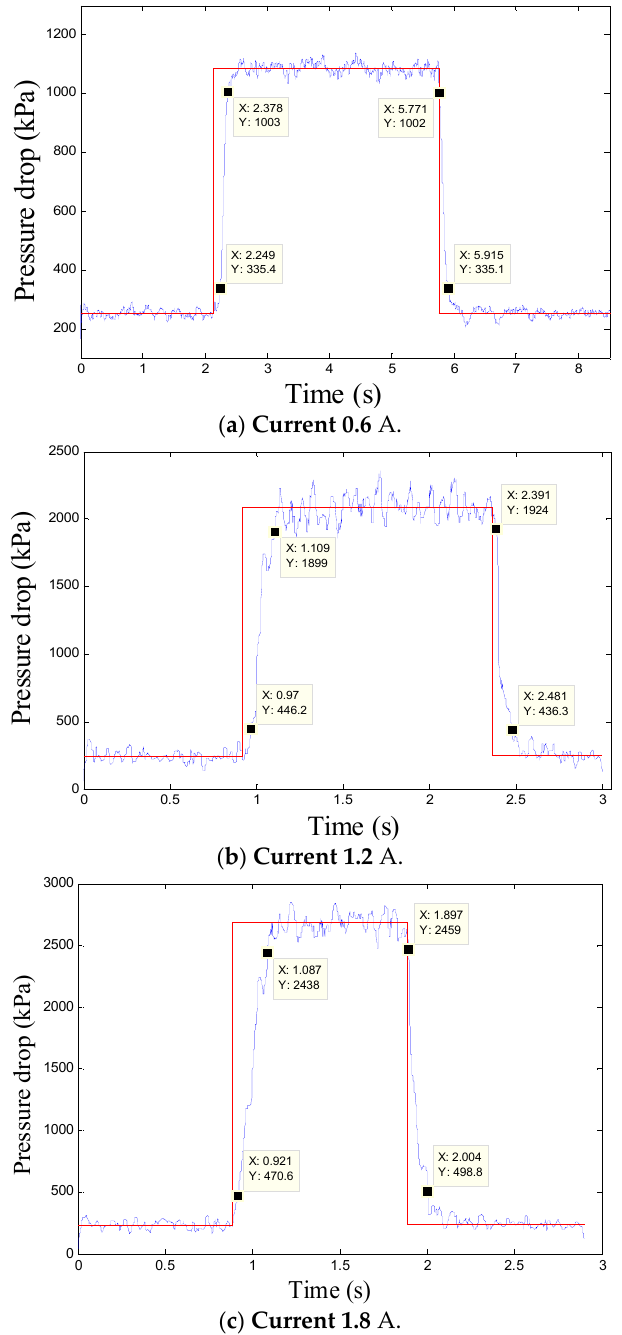
Figure 25. Step response diagram of the optimal radial MR